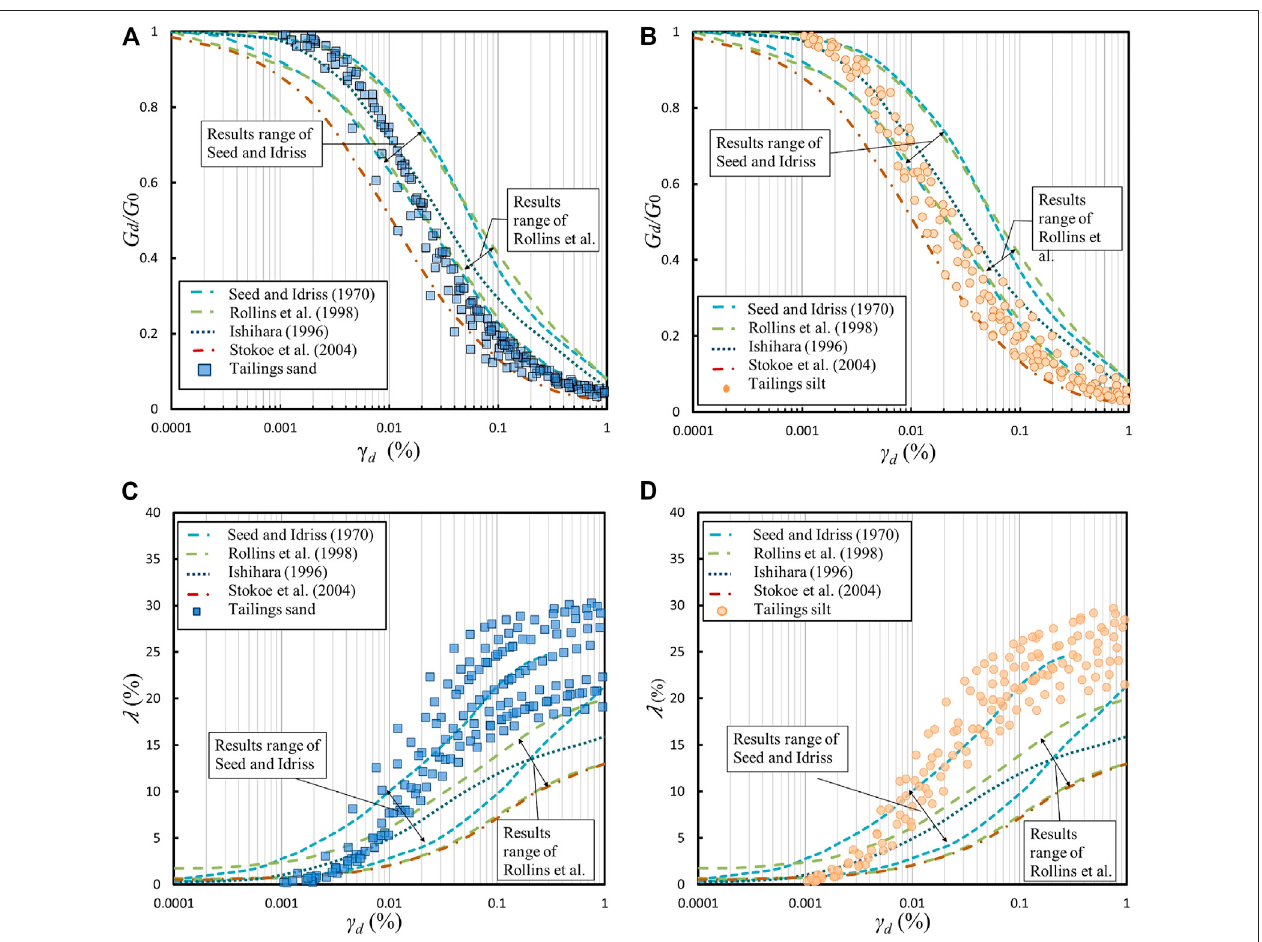
FIGURE 4 | Comparison of the dynamic deformation characteristics of the tailings and natural sands: (A) G d / G 0 ~ γ d curves of the tailings sand; (B) G d / G 0 ~ γ d curves of the tailings silt; (C) λ d ~ γ d curves of the tailings sand; and (D) λ d ~ γ d curves of the tailings silt.